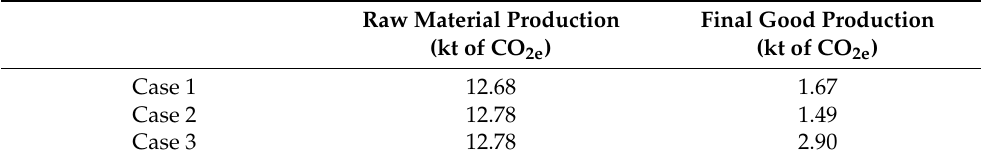
Table 37. CF differentiating the raw material production from the production of the